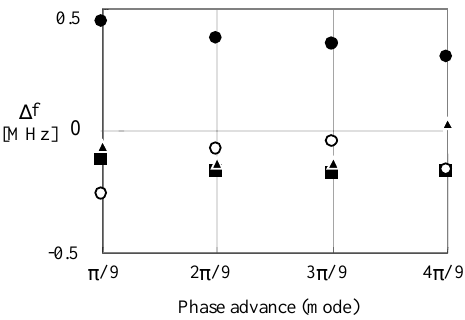
FIG. 10. Frequency deviation from the mean values for Cu models of a 9-cell TTF cavity: cavity No. 1 (cid:115) (cid:100) (cid:100) , cavity No. 2 (cid:115) (cid:106) (cid:100) , cavity No. 3 (cid:115) (cid:115) (cid:100) , and cavity No. 4 (cid:115) (cid:109) (cid:100)